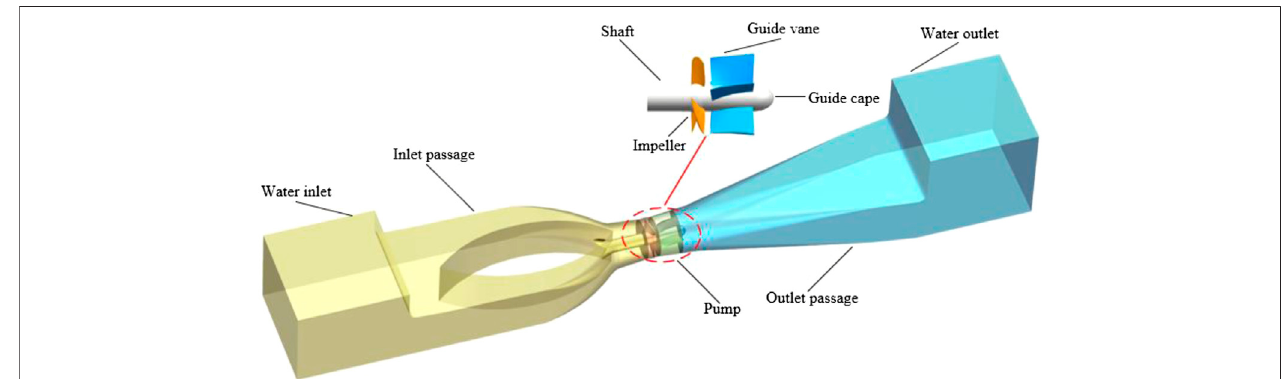
FIGURE 1 | Computational